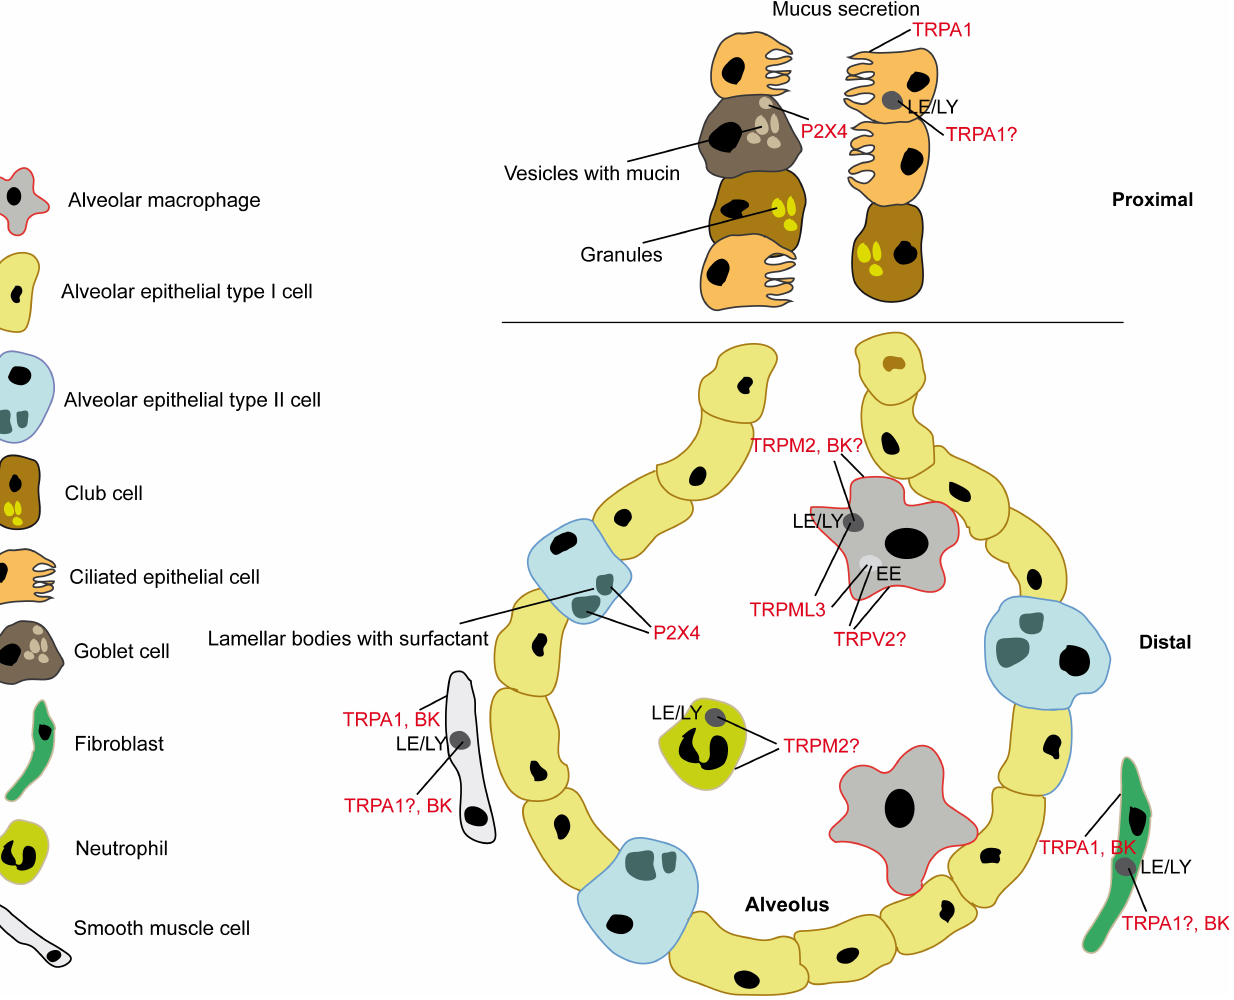
Figure 1. Schematic of an alveolus showing expression of confirmed and putative endolysoso- mal/vesicular/LRO cation channels involved in lung physiology and disease in the different alveo- lar/lung cell types. Black labeled compartments represent